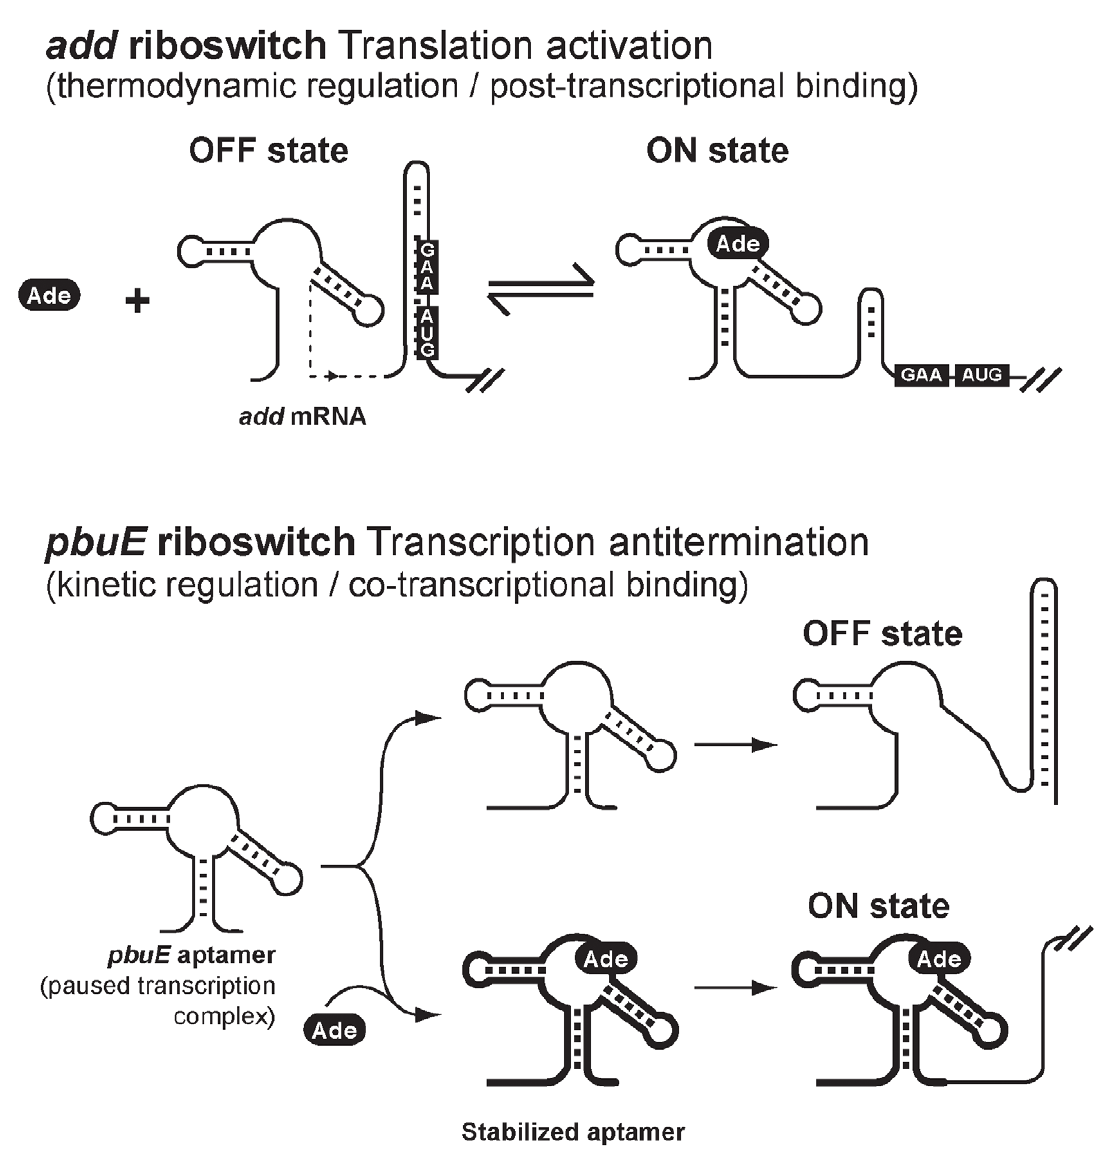
sequestrator helix. Upon adenine (Ade) binding, the ON state is formed which increases the accessibility of both GAA and AUG sequences. The structural reversibility and the lack of requirement of a transcription-translation coupling for the regulatory activity of the riboswitch are